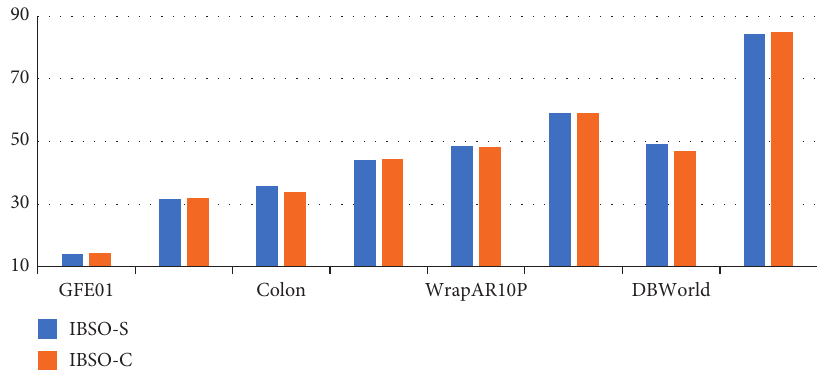
Figure 3: FN values of IBSO-C and IBSO-S.